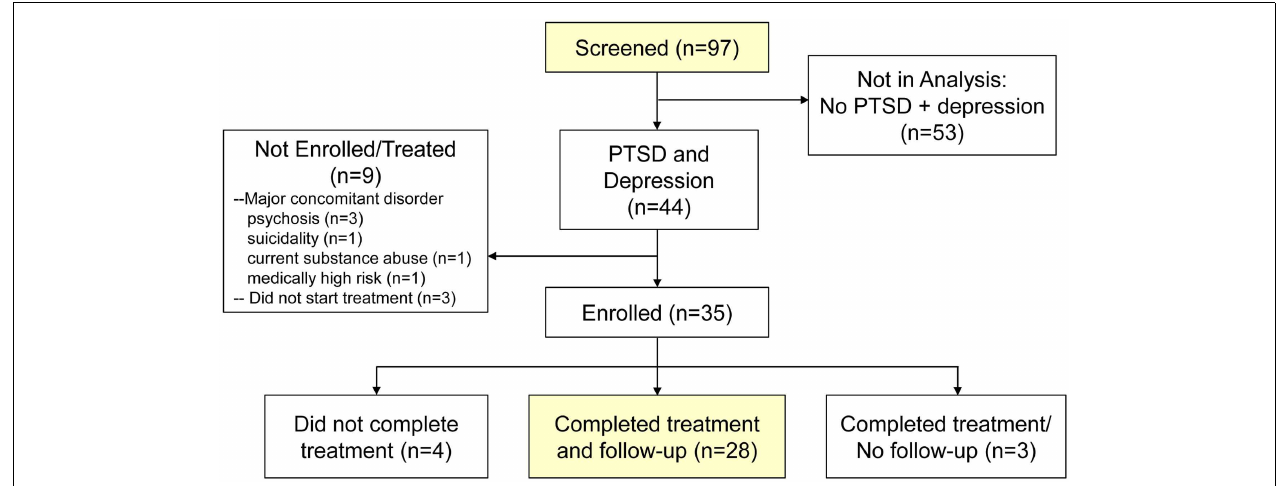
FIGURE 1 | Flow diagram of screening, enrollment, and treatment completion of study